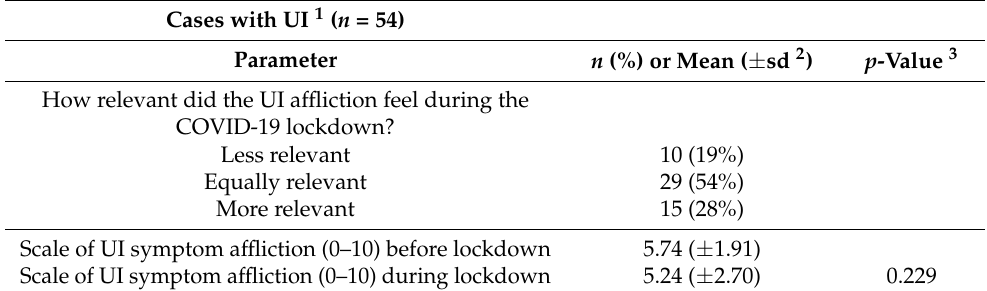
Table 3. Changes in relevance and affliction of urinary incontinence symptoms during COVID- 19 lockdown.